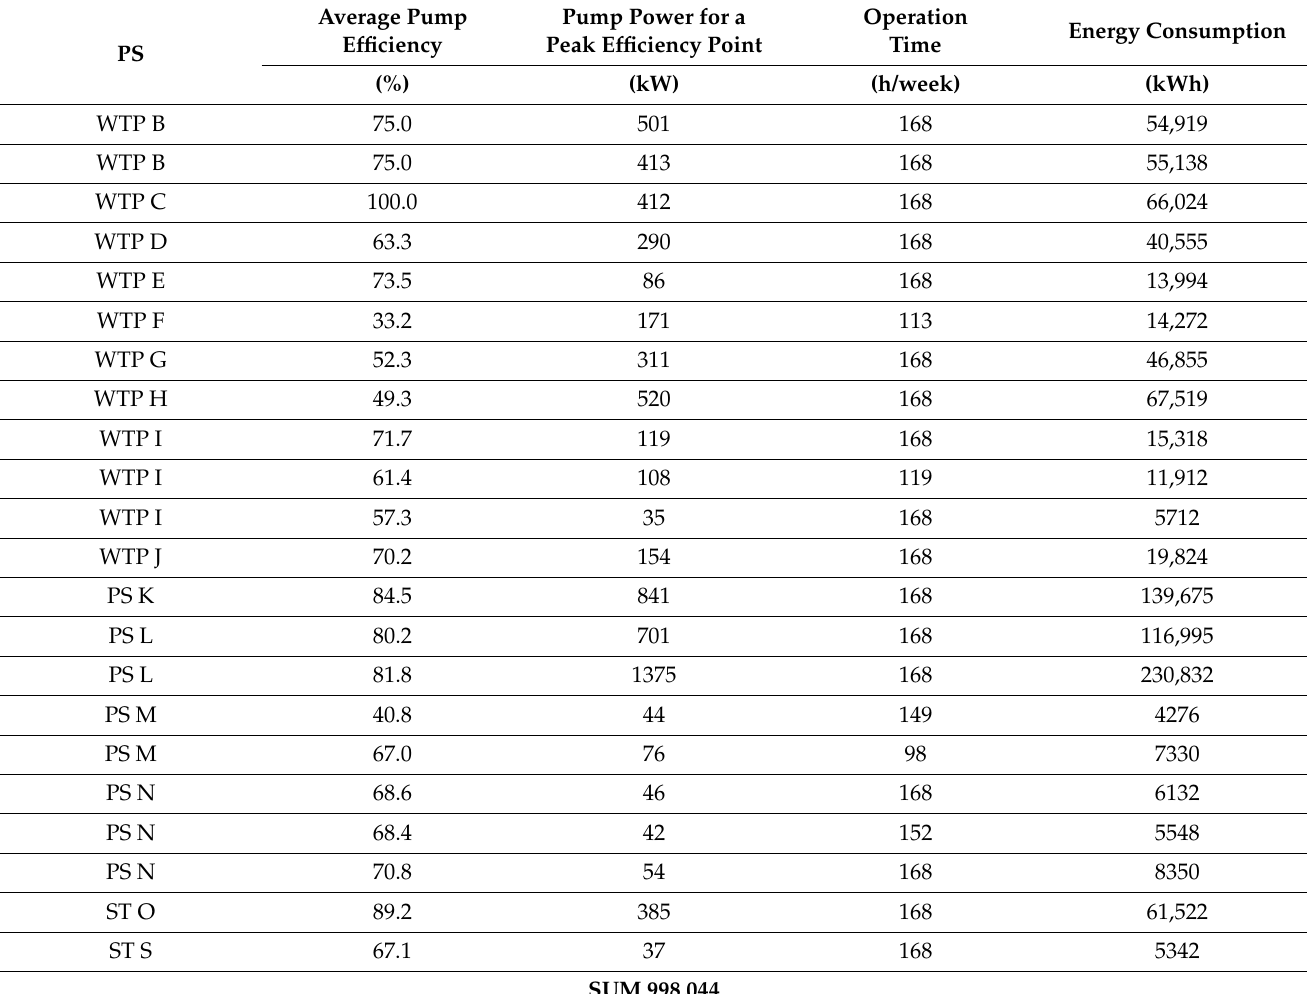
Table 4. The results obtained in Scenario 1.